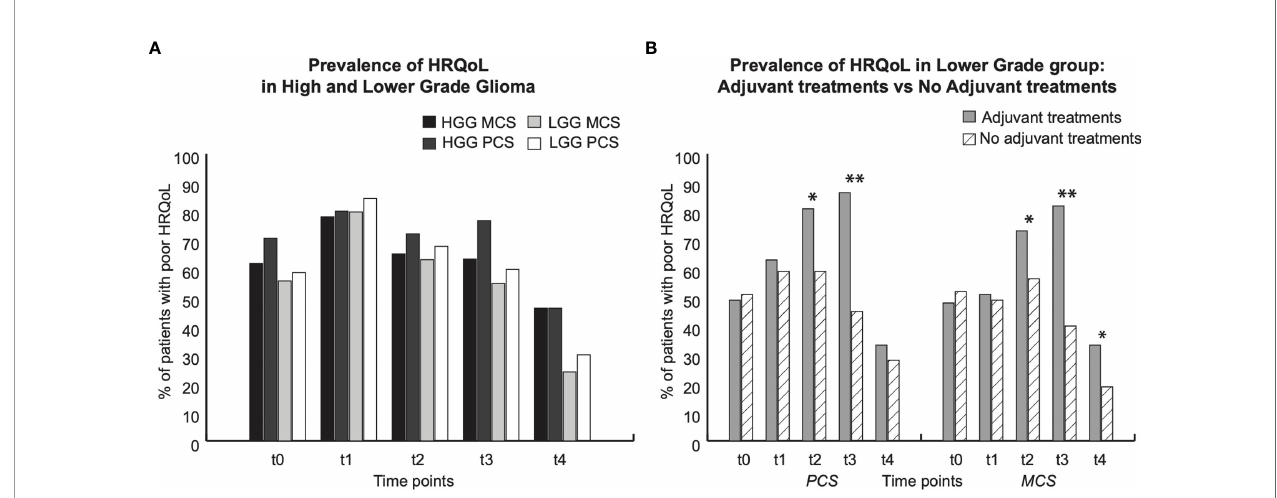
FIGURE 3 | Prevalence of low HRQoL (SF36 score). For each group, graphs show data at each time point: t0 (pre surgery); t1 (1 month after surgery); t2, t3 and t4 (respectively 3, 6 and 12 months after surgery). * indicate p < 0,05; ** p < 0,01. (A) Prevalence of low HRQoL in High (black and dark grey bars) and Lower (light grey and white bras) group. Dark Black and light grey bars show prevalence of Mental component score (MCS); light black and white bars show prevalence of Physical component score (PCS). (B) Prevalence of low HRQoL in lower grade group: Grey bars patients who underwent adjuvant treatments, dashed white bars: patients who did not undergo adjuvant